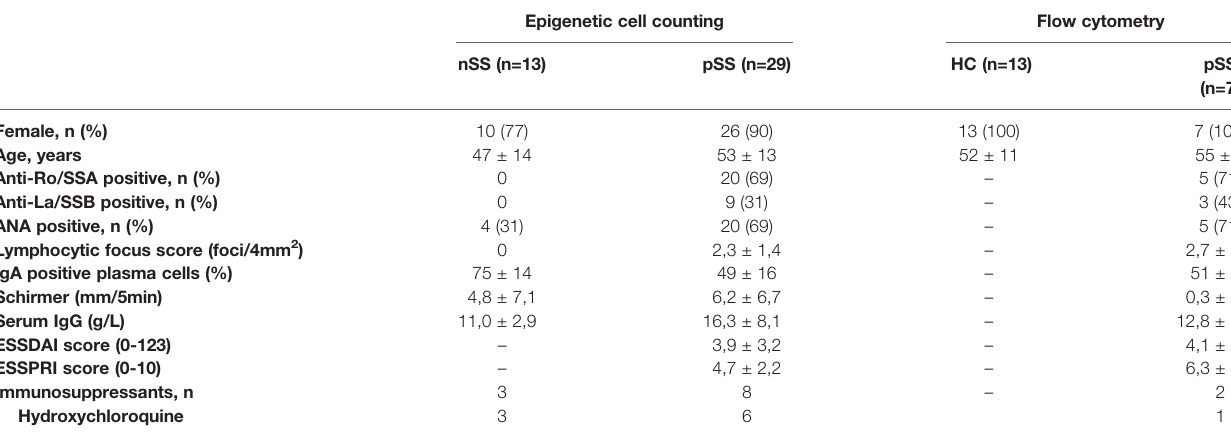
TABLE 1 | Participants ’